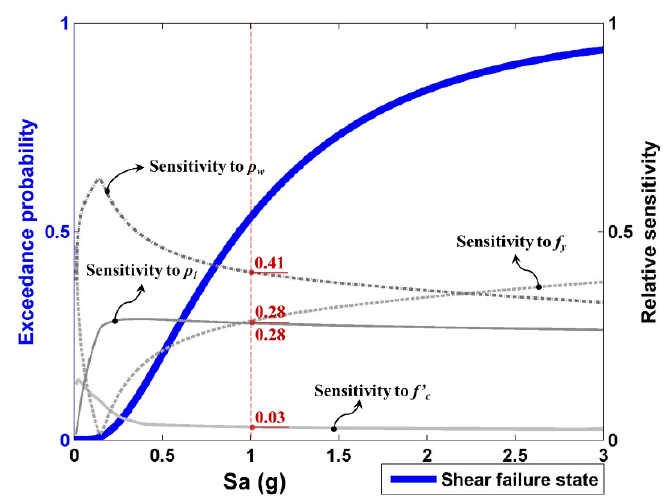
Figure 11. Shear vulnerability curve and relative sensitivity.